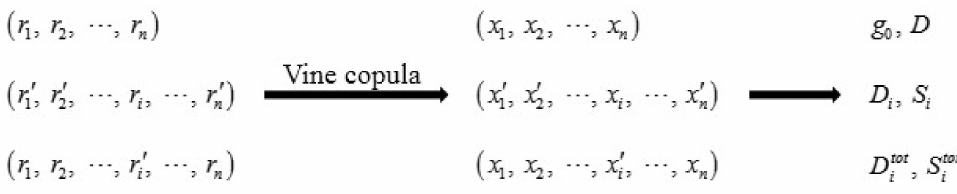
Figure 3. The solution process of VC1.